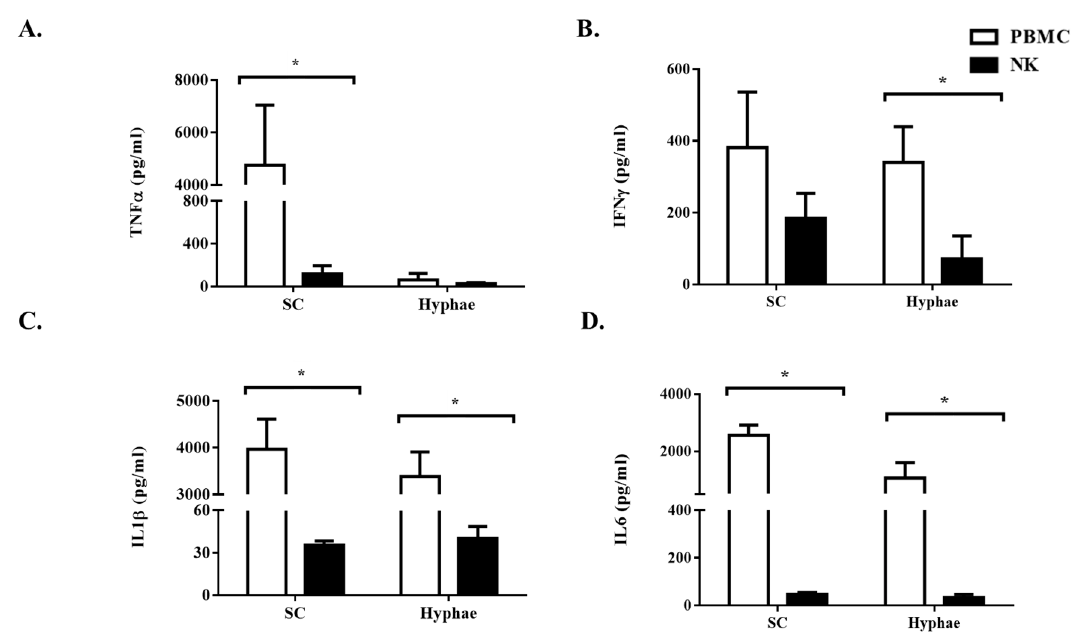
Figure 3. Cytokine production by expanded NK cells. ( A )—TNF- α ; ( B )—IFN- γ ; ( C )—IL1 β ; ( D )—IL6 in the supernatants of expanded NK cells and PBMC exposed to different morphotypes of A. fumigatus were assessed by ELISA. Expanded NK cells and PBMC were co-incubated with live Aspergillus morphotypes for 6 h. Data shown is representative of the mean of duplicate readings (± SEM) pooled from 5 experiments. * p < 0.05 for PBMC compared to expanded NK cells.